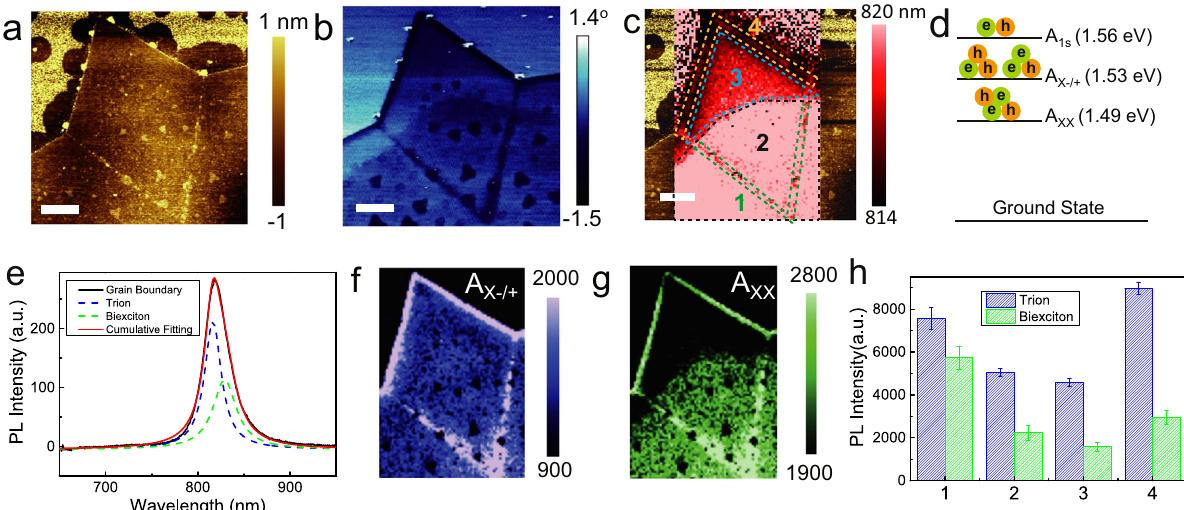
Fig. 3 Correlation of KPFM to TEPL in monolayer MoSe 2 fl akes. a Topography b KPFM phase, and c near- fi eld PL wavelength mapping of monolayer MoSe 2 , d Energy diagram of exciton, trion, and biexciton state, e representative deconvoluted averaged PL Spectrum of Region 1, f Near fi eld PL mapping of A X − / + (~1.520 eV) and g A XX (~1.490 eV), and h Areal PL contribution of trion and biexciton at Region 1 – 4. All scale bars are equivalent to 3